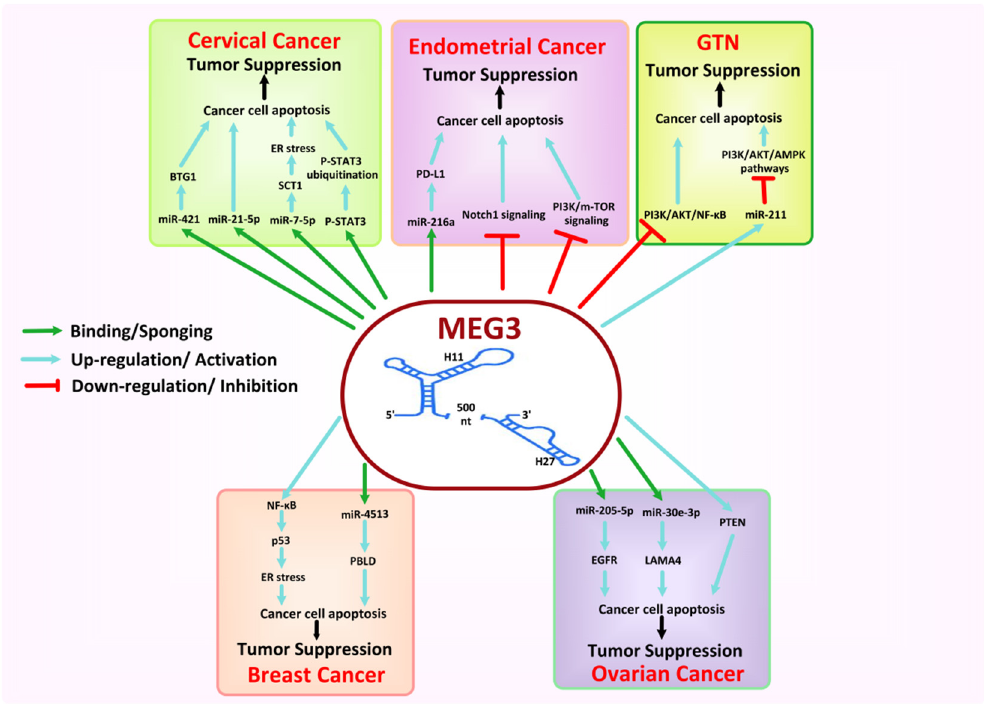
Figure 8. Mechanisms associated with the tumor suppressor of MEG3 in female-oriented cancers. Several LncRNAs involved in proliferation, invasion, apoptosis, migration, metastasis, and drug resistance in female-orieted cancers are briefly discussed in Tables 1–6. Table 1. LncRNAs involved in proliferation, invasion, apoptosis, migration, metastasis, and drug resistance in breast cancers. LncRNAs